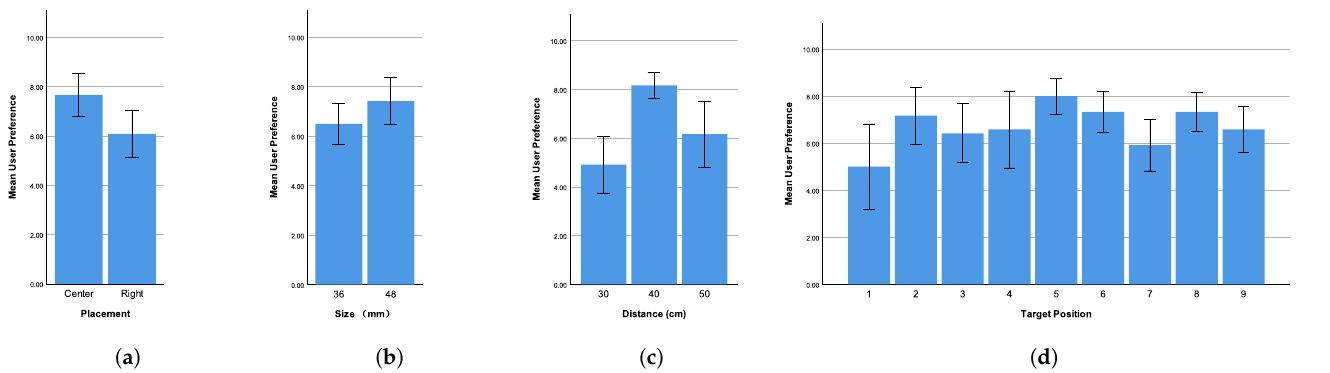
Figure 5. Mean user preference. ( a ) Target Placement; ( b ) Target Size; ( c ) Target Distance; ( d ) Target